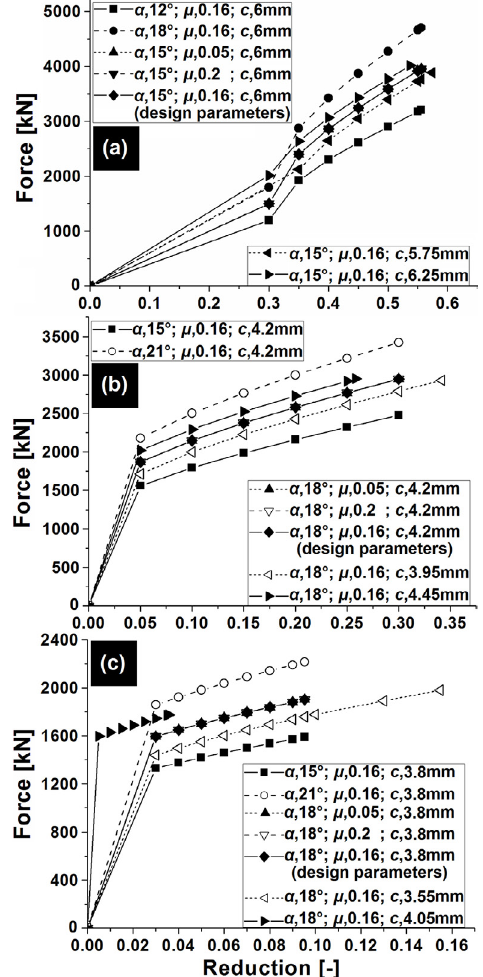
Figure 8. Graphical showing of influences of three process parameters ( α, μ, c ) all together on ironing punch force, (a) 1 st draw, (b) 2 nd draw, and (b) 3 rd draw.